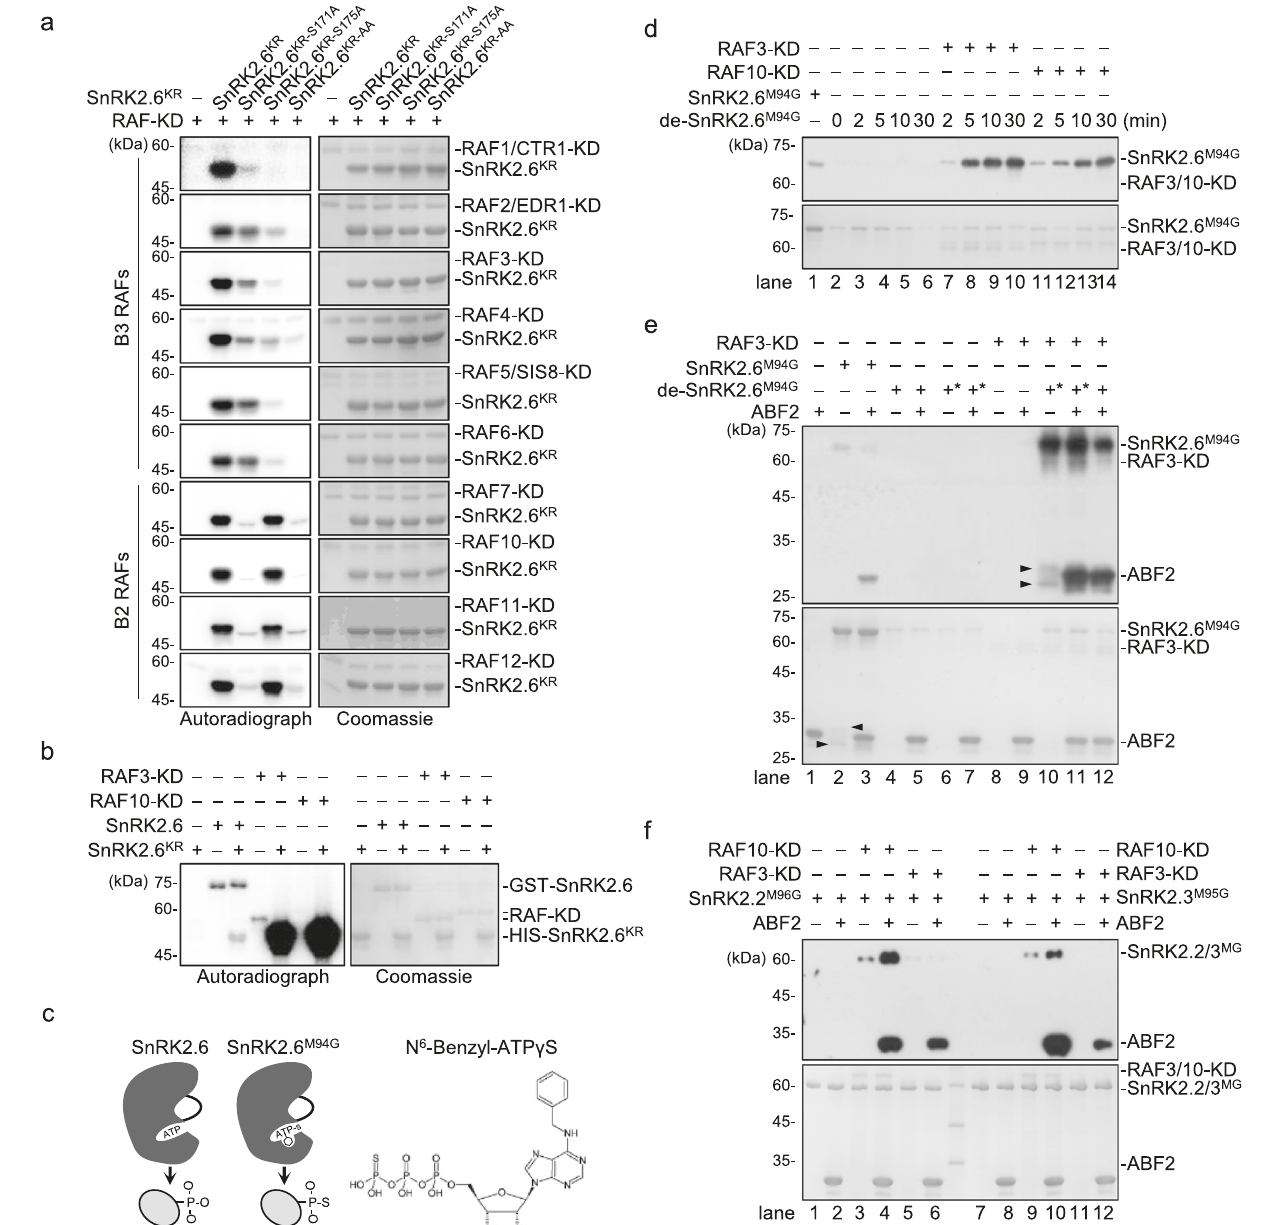
Fig. 1 SnRK2.6 activation requires transphosphorylation by B2 and B3 RAFs in vitro. a Recombinant RAF kinase domains (KDs) were used to phosphorylate SnRK2.6 KR (SnRK2.6 K50R , a kinase-dead form of SnRK2.6), SnRK2.6 KR with Ser171Ala mutation (SnRK2.6 KR-S171A ), SnRK2.6 KR with Ser175Ala mutation (SnRK2.6 KR-S175A ), or SnRK2.6 KR proteins with Ser171AlaSer175Ala mutations (SnRK2.6 KR-AA ), in the presence of [ γ - 32 p]ATP. Autoradiograph (left) and Coomassie staining (right) show phosphorylation and loading, respectively, of puri fi ed GST-RAF-KD and HIS-SnRK2.6 KR . b GST- SnRK2.6, HIS-SUMO-RAF3-KD, and HIS-SUMO-RAF10-KD phosphorylate HIS-SnRK2.6 KR in vitro. Recombinant undephosphorylated GST-SnRK2.6 was used to phosphorylate HIS-SnRK2.6 KR in the presence of [ γ - 32 p]ATP. Autoradiograph (left) and Coomassie staining (right) show phosphorylation and loading, respectively, of puri fi ed GST-SnRK2.6, HIS-SUMO-RAF3-KD, HIS-SUMO-RAF10-KD, and HIS-SnRK2.6 KR . c SnRK2.6 M94G but not wild type SnRK2.6 can use N 6 -Benzyl-ATP γ S to thiophosphorylate substrate. d RAF3-KD and RAF10-KD trigger the autophosphorylation of pre-dephosphorylated GST-SnRK2.6 M94G (de-SnRK2.6 M94G ). e RAF3-KD activates pre-dephosphorylated GST-SnRK2.6 M94G (de-SnRK2.6 M94G ) and the reactivated SnRK2.6 M94G phosphorylates itself and ABF2. f RAF3-KD and RAF10-KD activate HIS-SUMO-SnRK2.2 M96G and HIS-SUMO-SnRK2.3 M95G . For d to f , Anti- γ -S immunoblot (upper) and Coomassie staining (lower) show thiophosphorylation and loading, respectively, of recombinant GST-RAF3-KD, GST-RAF10- KD, GST-SnRK2.6 M94G , HIS-SUMO-SnRK2.2 M96G , HIS-SUMO-SnRK2.3 M95G , and GST-ABF2. Asterisks indicate preincubation of SnRK2.6 M94G with N 6 - Benzyl-ATP γ S for 30 min before further reaction. Arrows indicate degraded fragments co-puri fi ed with GST-SnRK2.6 M94G . Images shown are representative of at least two independent experiments. Source data are provided in Source Data.